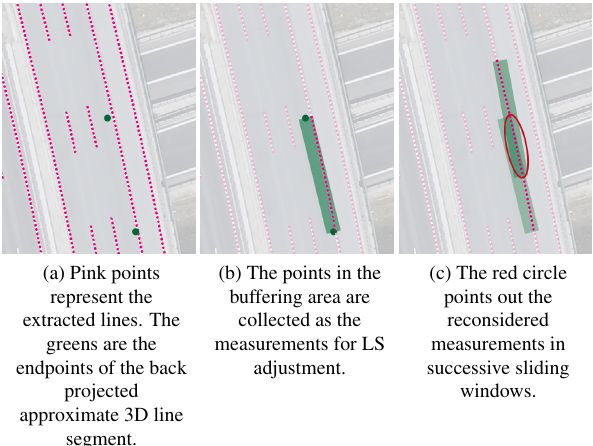
Figure 5. 3D reconstruction of a lane marking by a sliding window.